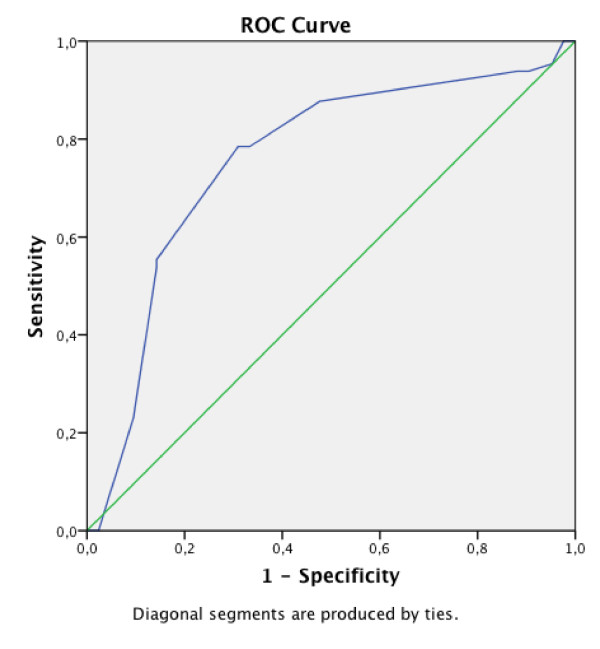
ROC curve of the WOMAC total score. A percent change of -16% generated from the ROC analyses were optimal cut-off point associated with our definition of MCID, namely the transition category of "slightly better". The sensitivity and specificity of the cut-off point were 75% and 68% respectively.